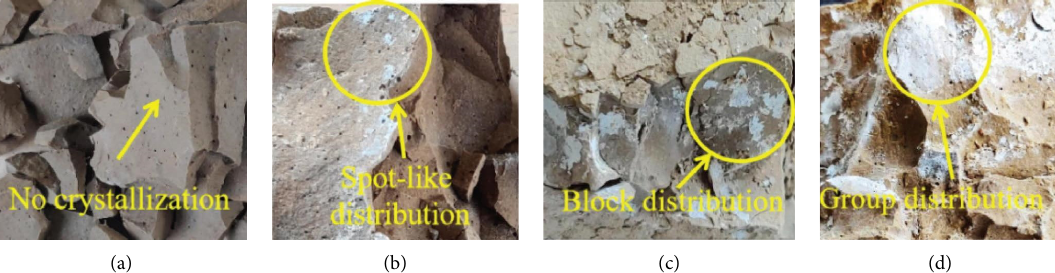
Figure 10: Internal characteristics of the cemented soil without glass fbers after 5 freezing-thawing cycles in (a) water environment; (b) potassium acetate environment; (c) magnesium chloride environment; (d) sodium sulfate